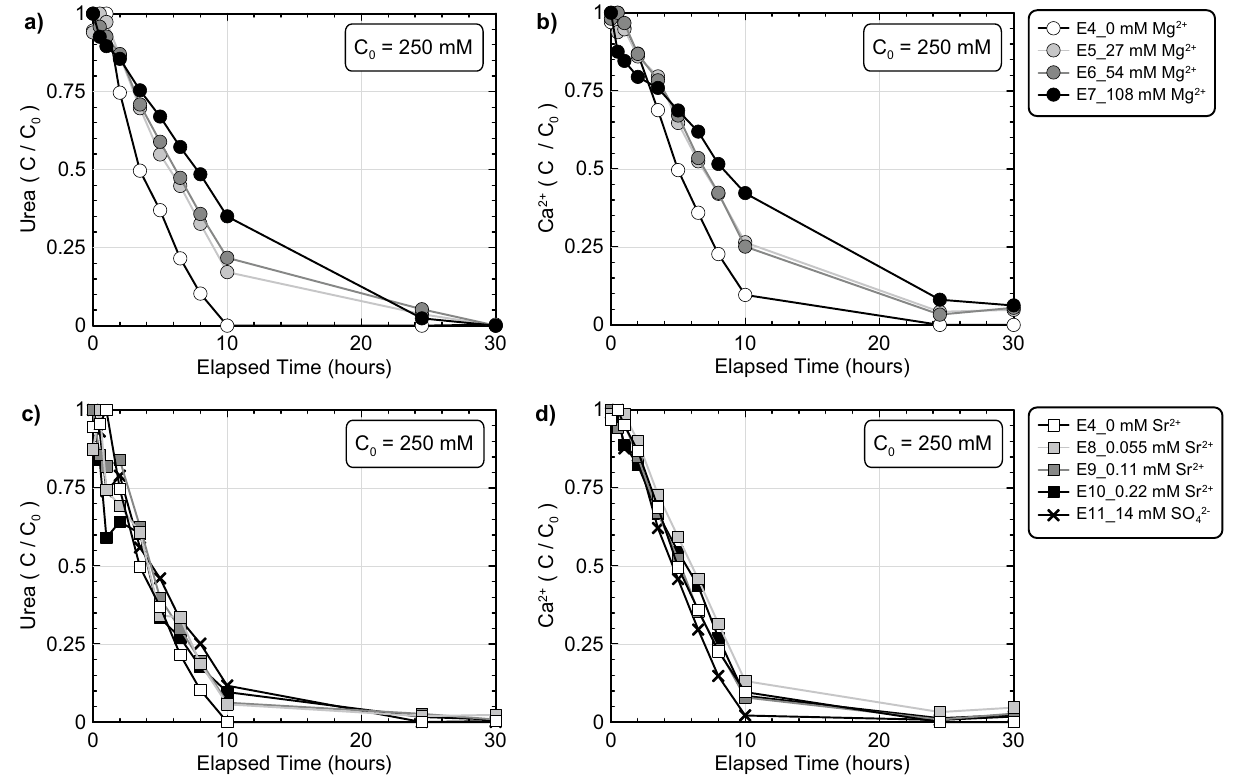
Figure 4. Normalized concentrations of ( a, c ) urea and ( b, d ) Ca 2+ in time for ( a, b ) Mg 2+ varied experiments and ( c, d ) Sr 2+ and SO 4 −2 varied experiments. All experiments included the addition of 250 mM urea, 250 mM Ca 2+ , S. pasteurii cells at 7.1 × 10 7 cells/mL, and varying Mg 2+ , Sr 2+ , or SO 4 2− additions.